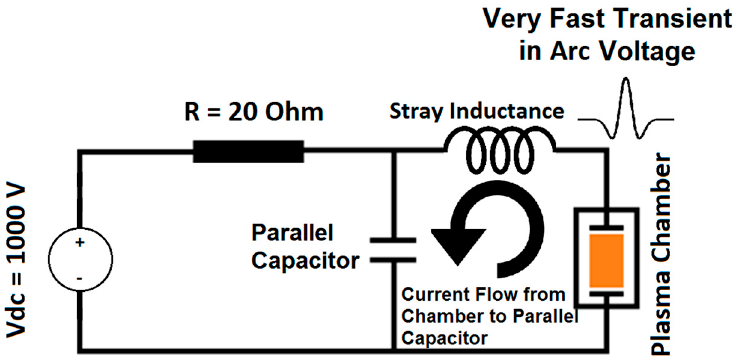
Figure 5. The external circuit of the plasma chamber, which is equipped by a parallel capacitor.